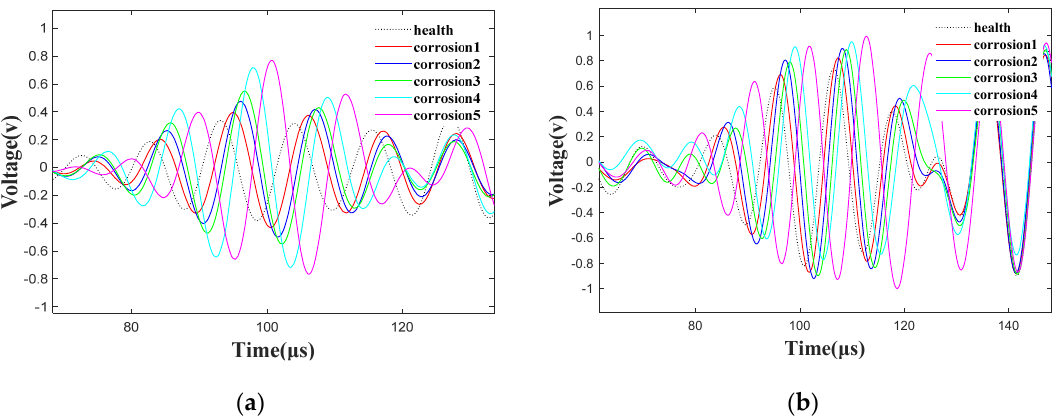
Figure 14. Partial enlargement of A0 wave packet of health signal and five times corrosion damage received signal of ( a ) sensor pair 2–5; ( b ) sensor pair 3–6.